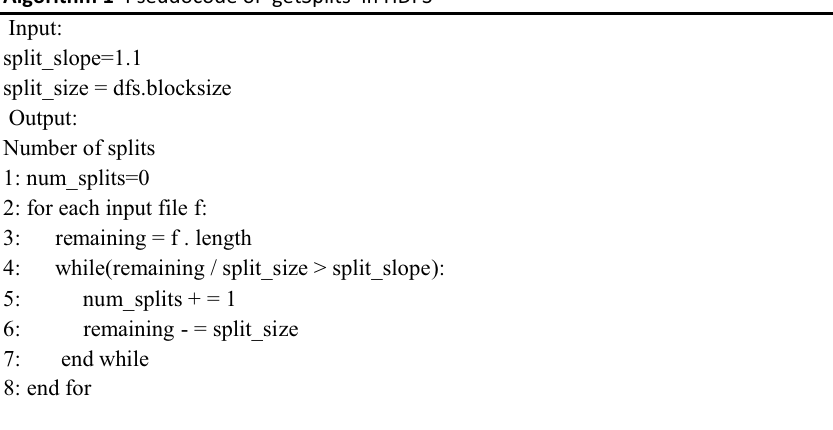
Algorithm 1 Pseudocode of getSplits in HDFS